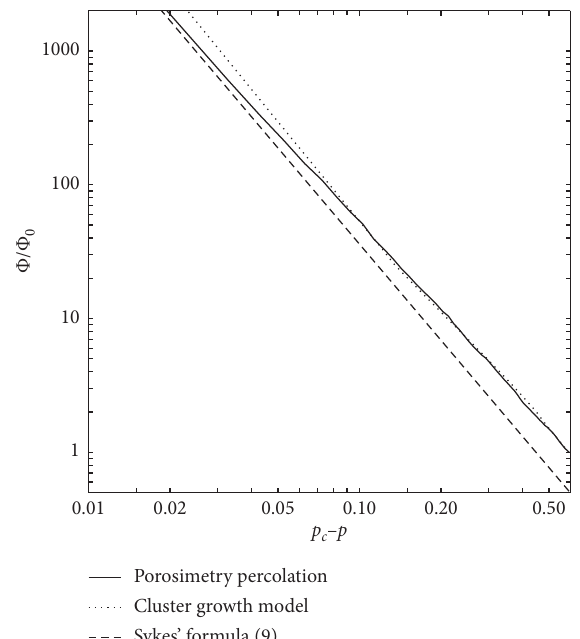
Figure 10: Φ scaled with the starting size Φ Table 1: Mean and RMS of the relative errors ( Φ Case | Φ